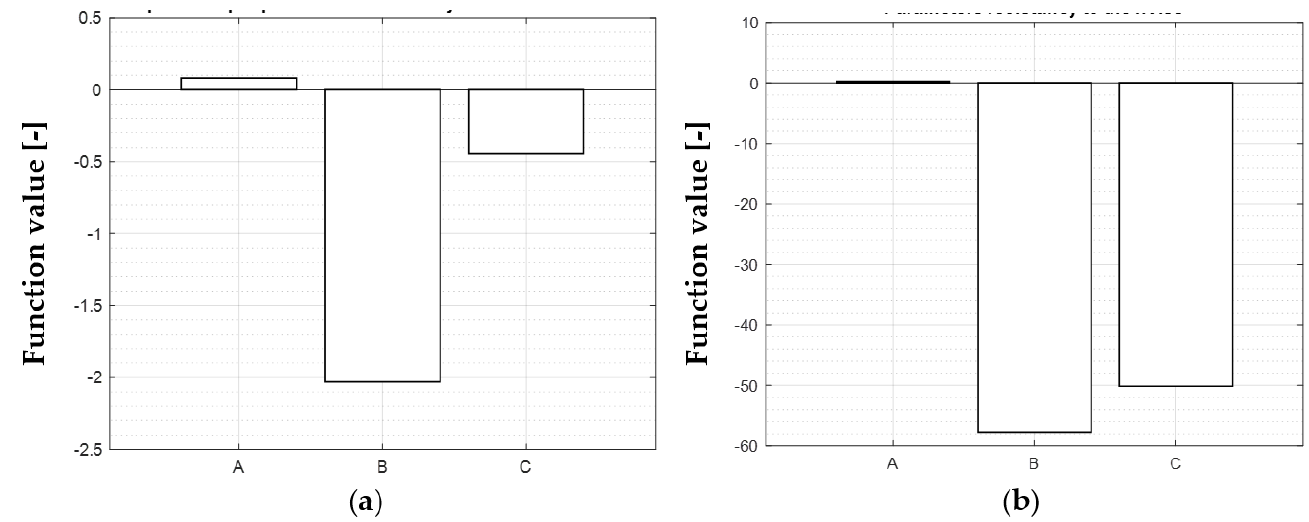
Figure 5. Parametric optimization results; ( a )—impact of input parameters with impact increasing: B, C, A; ( b )—input parameters’ resistance to noise with resistance increasing: A, C, B.